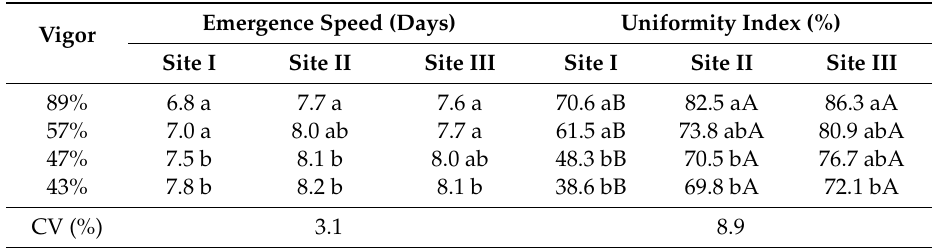
Table 1. Average time of emergence (emergence speed) in days and uniformity index in percentage from soybean seeds with di ff erent vigor levels (89, 57, 47, and 43%) at three sites (I, II, and III). Emergence Speed (Days) Uniformity Index (%) Vigor Site I Site II Site III Site I Site II Site III 89% 6.8 a 7.7 a 7.6 a 70.6 aB 82.5 aA 86.3 aA 57% 7.0 a 8.0